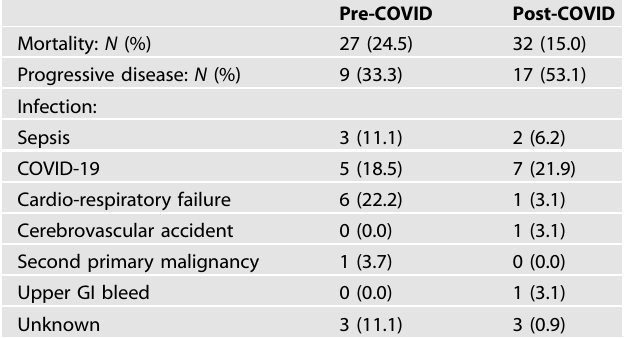
Table 2. Cause of death for patients diagnosed from 01